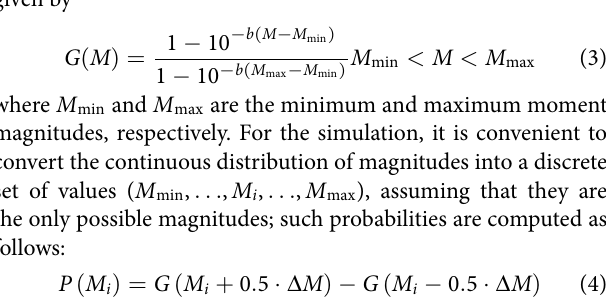
(Gutenberg and Richter, 1956) is adopted, and its CCDF